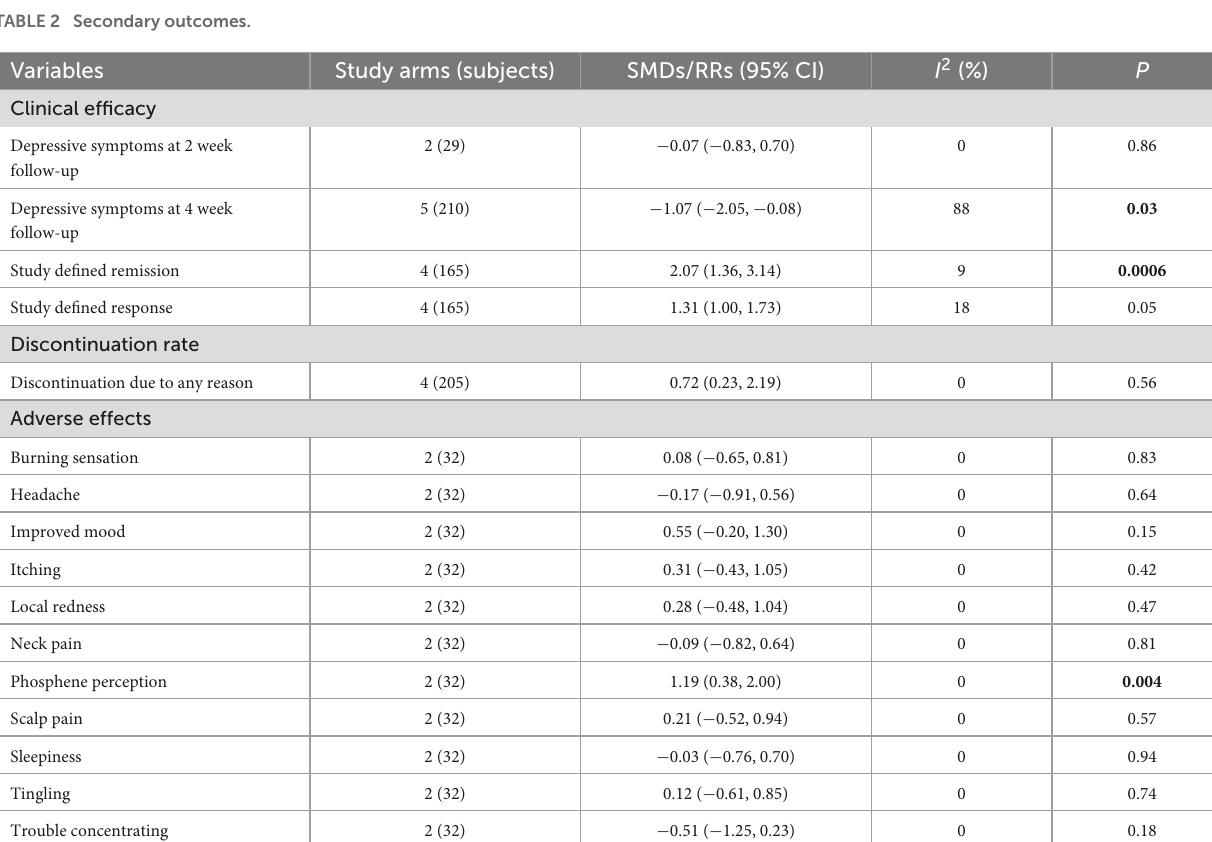
TABLE 2 Secondary